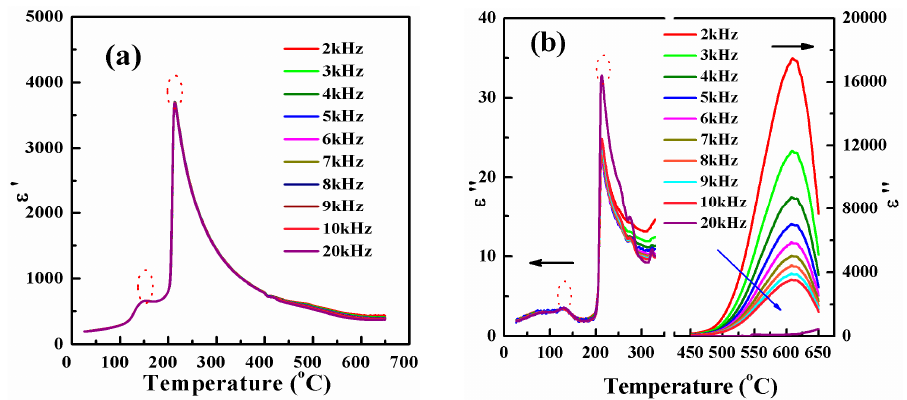
Figure 2. Temperature dependence of the: real ε ' ( a ) and; imaginary ε '' ( b ) parts of the dielectric permittivity for PLZT2/95/5 ceramics at various frequencies.